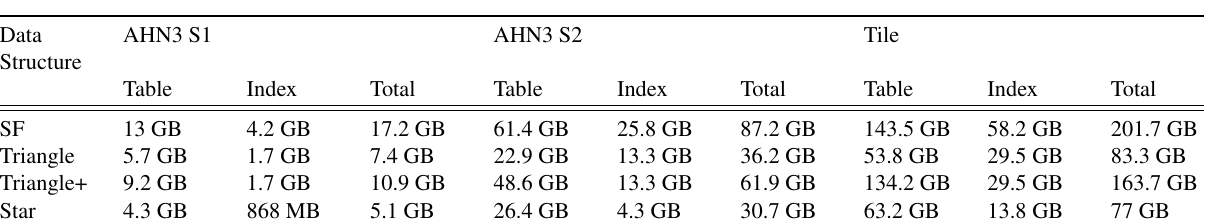
Table 4: Storage size in